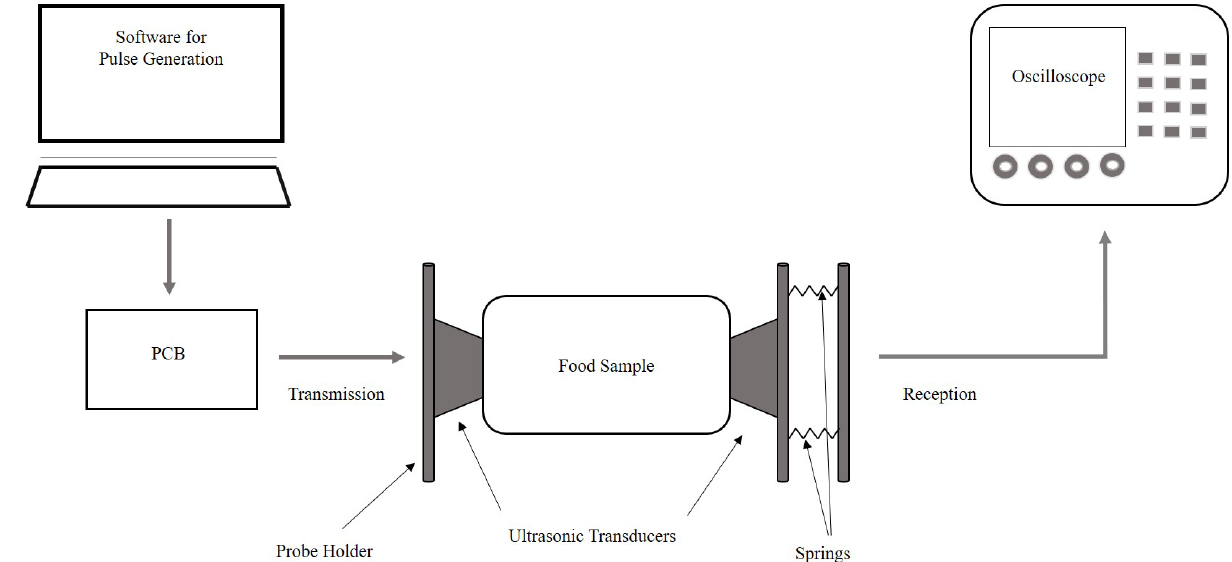
Figure 2. Setup designed for the ultrasonic measurement system. The system consists of electronics and software to drive the ultrasonic transducers placed in 3-D printed holders and is supported using springs and metal rods for mechanical stability and also for creating a holder for sample food of dimensions up to 20cm in length and 8cm in